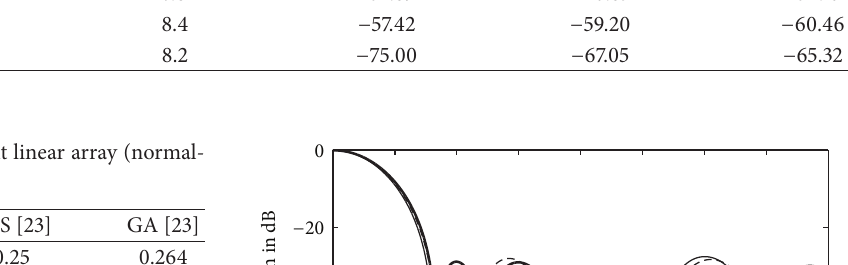
Table 3: Comparison with published results for 2𝑁 = 28 elements optimized with respect to position. SLL FNBW Example 1 ( 𝑅 = 0.05 )